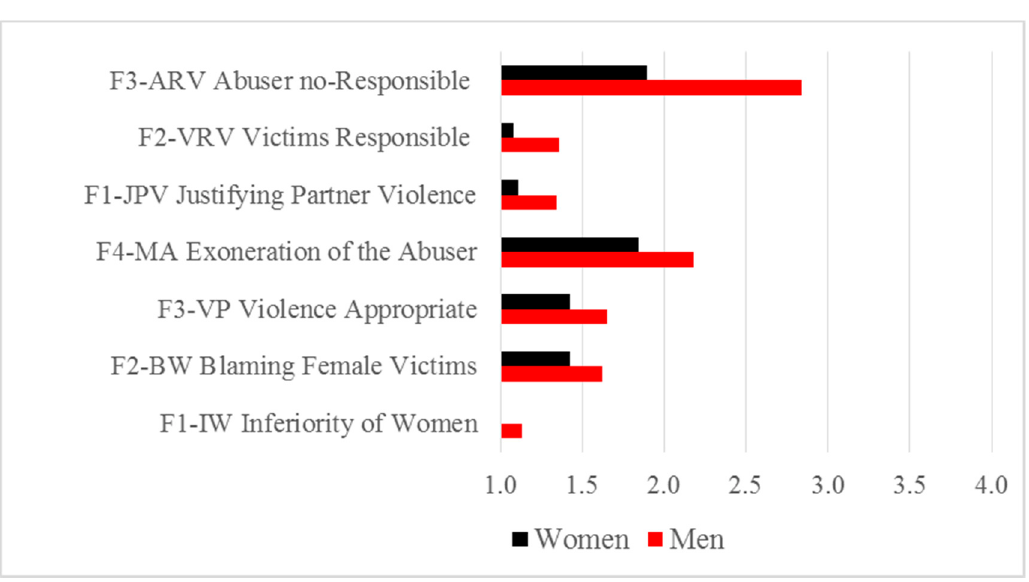
Figure 7. Means in explicit measures of attitudes toward IPVAW by gender ( ≤ 29 years).